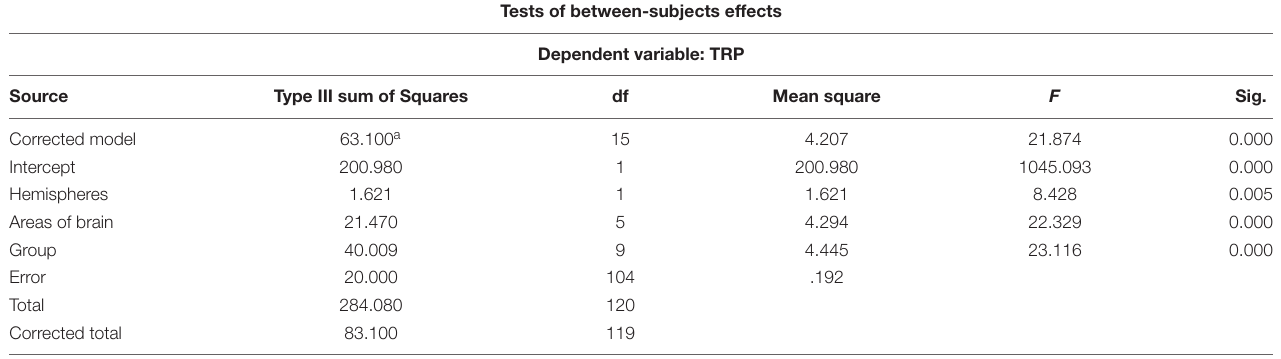
TABLE 6 | Analogy and inference: theta-band ANOVA.